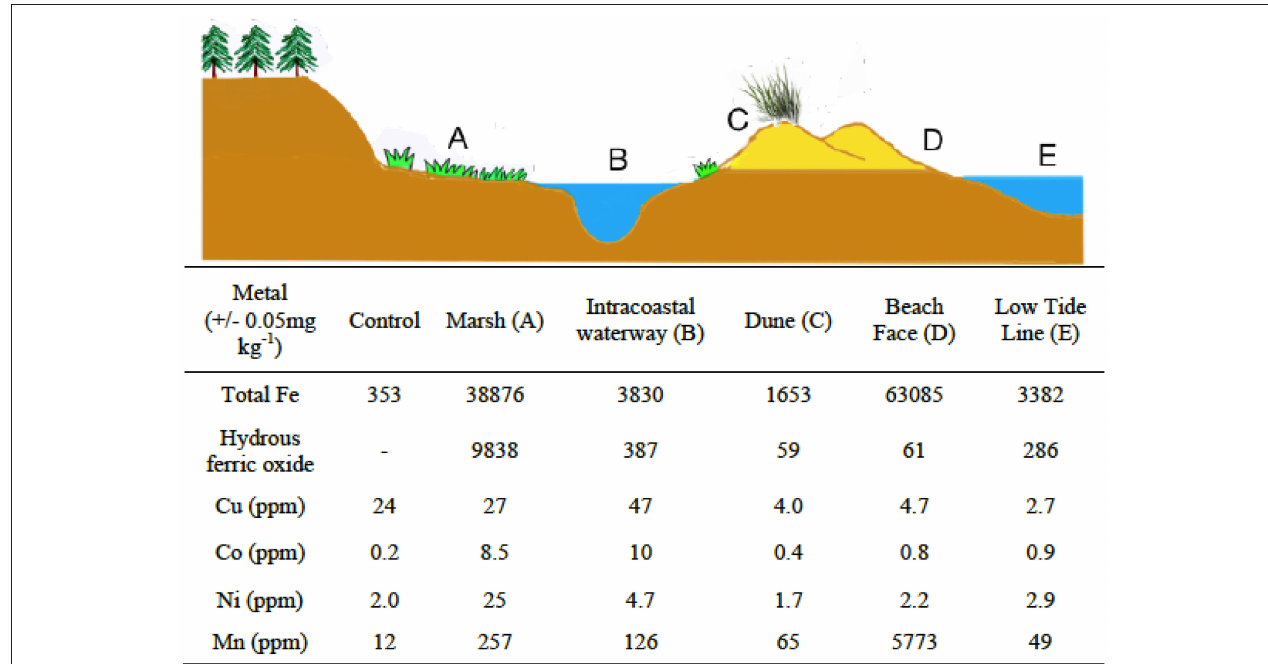
FIGURE 2 | Sediment collection points and metal content (dry weight). Sediment surface samples were collected from several points across the South Carolina marine littoral zone, including a coastal marsh (A) , manmade intracoastal water way (B) , a barrier island dune crest (C) , the beach face or swash zone (D), and at a depth of 1m below the low tide line (E) . Samples were sieved (4mm) and air dried before analysis for metals or use in experiments. The control sample was chromatographic sand treated with aqua regia and washed. Characterization for transition metals in all samples was achieved by acid extraction followed by inductively coupled plasma mass spectrometry or ascorbate/HCl extraction followed by Ferrozine (amorphous Fe